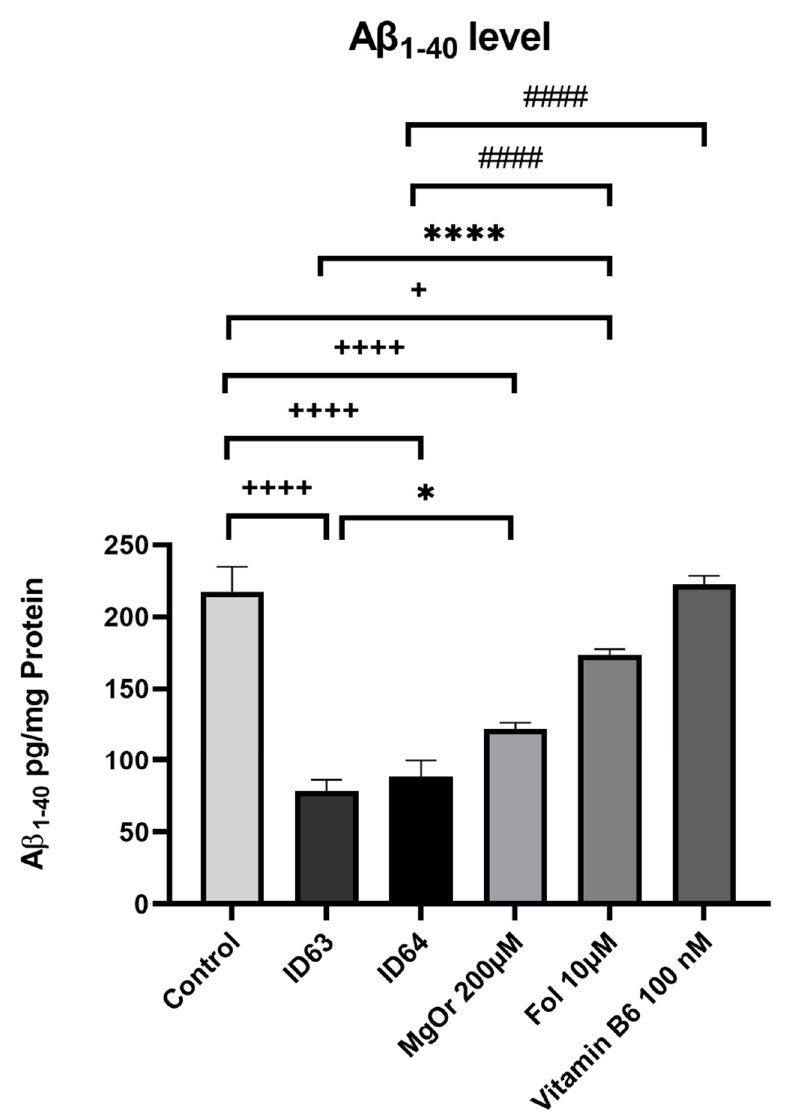
Figure 1. Effect of ID63 and ID64 in SH-SY5Y 695 cells compared to the control or their single substances on the A β 1–40 level after 24 h incubation. N = 6. A β 1–40 levels were adjusted to the protein content. Significance was determined by Student’s unpaired t -test and one-way ANOVA. + significant